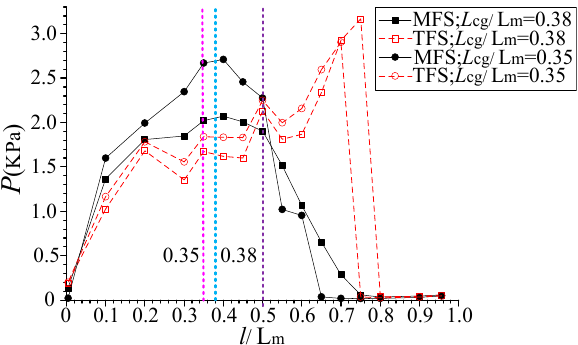
Figure 21. Pressure distribution from stern to bow on keel line in the MFS and TFS.